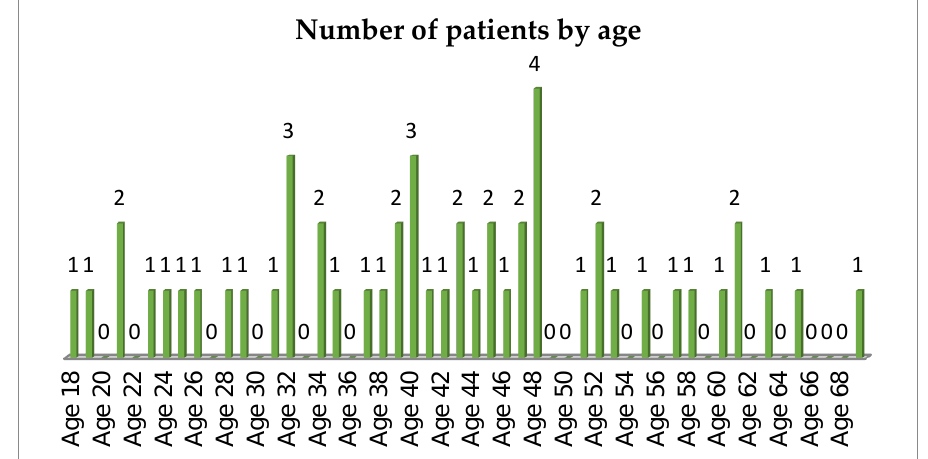
Figure 3. The number of patients by age.